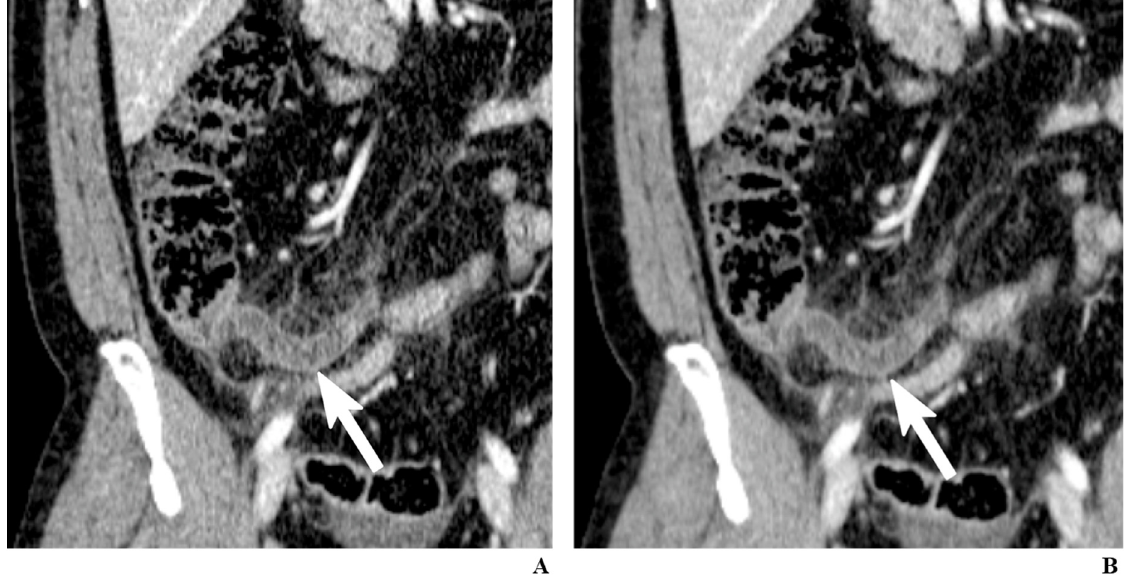
Figure 1. A 34-year-old man with appendicitis. Contrast-enhanced coronal CT images reconstructed by filtered back-projection (FBP) ( A ) and iterative reconstruction (IR) ( B ). While both images clearly depict an inflamed appendix (arrows), the image reconstructed using IR generates less noise, which can alleviate the practitioners’ reluctance to low-dose CT.